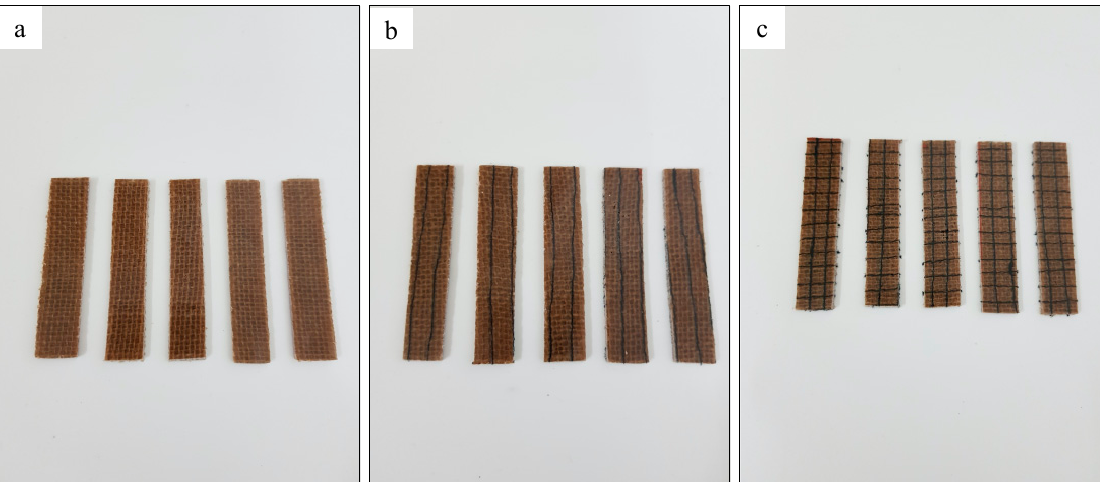
Figure 8. CEAST 9050 Izod impact test machine.